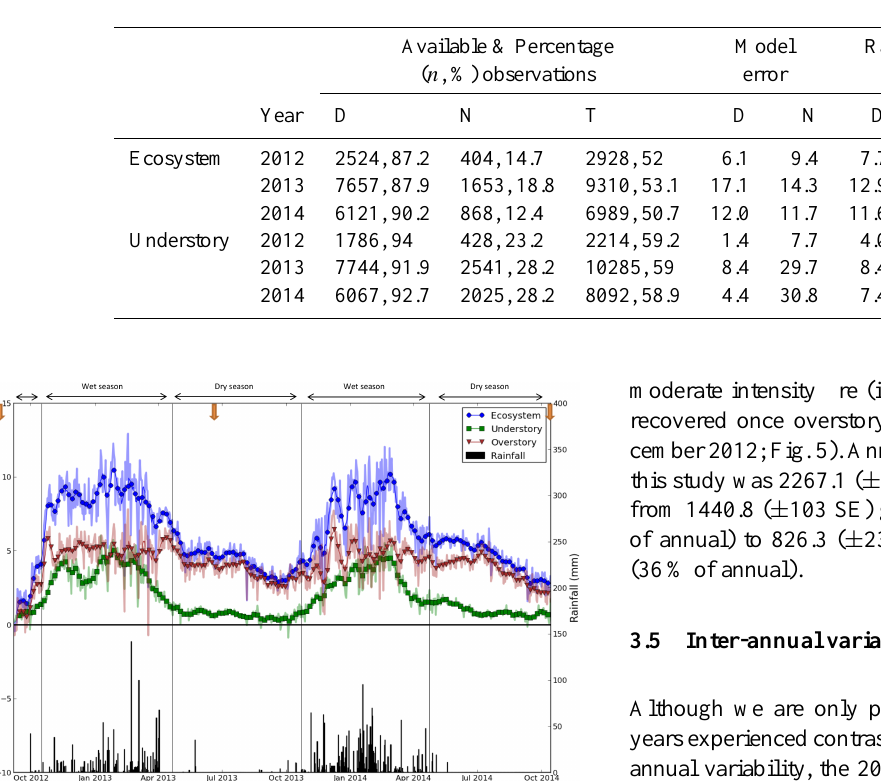
Table 4. Error estimates for net ecosystem exchange for the ecosystem and understory flux towers at Howard Springs OzFlux site, Northern Territory, Australia. Estimates are given for each year (2012–2014) and are presented as day (D), night (N) and total (T) error estimates in gCm − 2 t − 1 , where t is day, night or year.